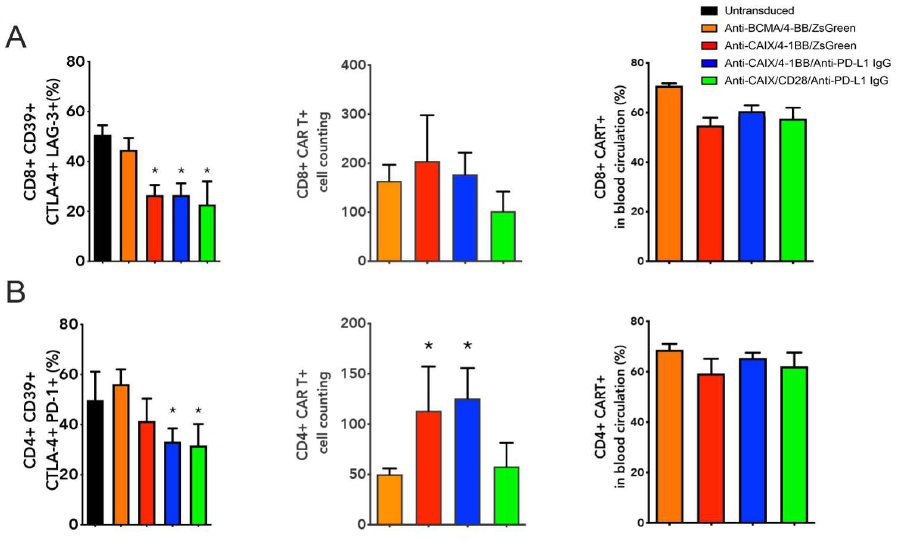
Figure 3. Immune profile of live peripheral CD8 and CD4 chimeric antigen receptor (CAR) T cells one month after the first T cell transfer. ( A ) Boolean analysis of all T cell exhaustion markers (CD39, CTLA-4, TIM-3, and PD-1) expressed by CD8 T cells; absolute cell count of CD8+ CAR T cells within gated live cells; and percentage of live peripheral CD8+ CAR T cells. ( B ) Boolean analysis of all T cell exhaustion markers (CD39, CTLA-4, TIM-3, and PD-1) expressed by CD4+ T cells; absolute cell count of CD4+ CAR T cells within gated live cells; and percentage of live peripheral CD8+ CAR T cells. Data determined by flow cytometry. * p < 0.05 compared to anti- B cell maturation antigen (BCMA) CAR.